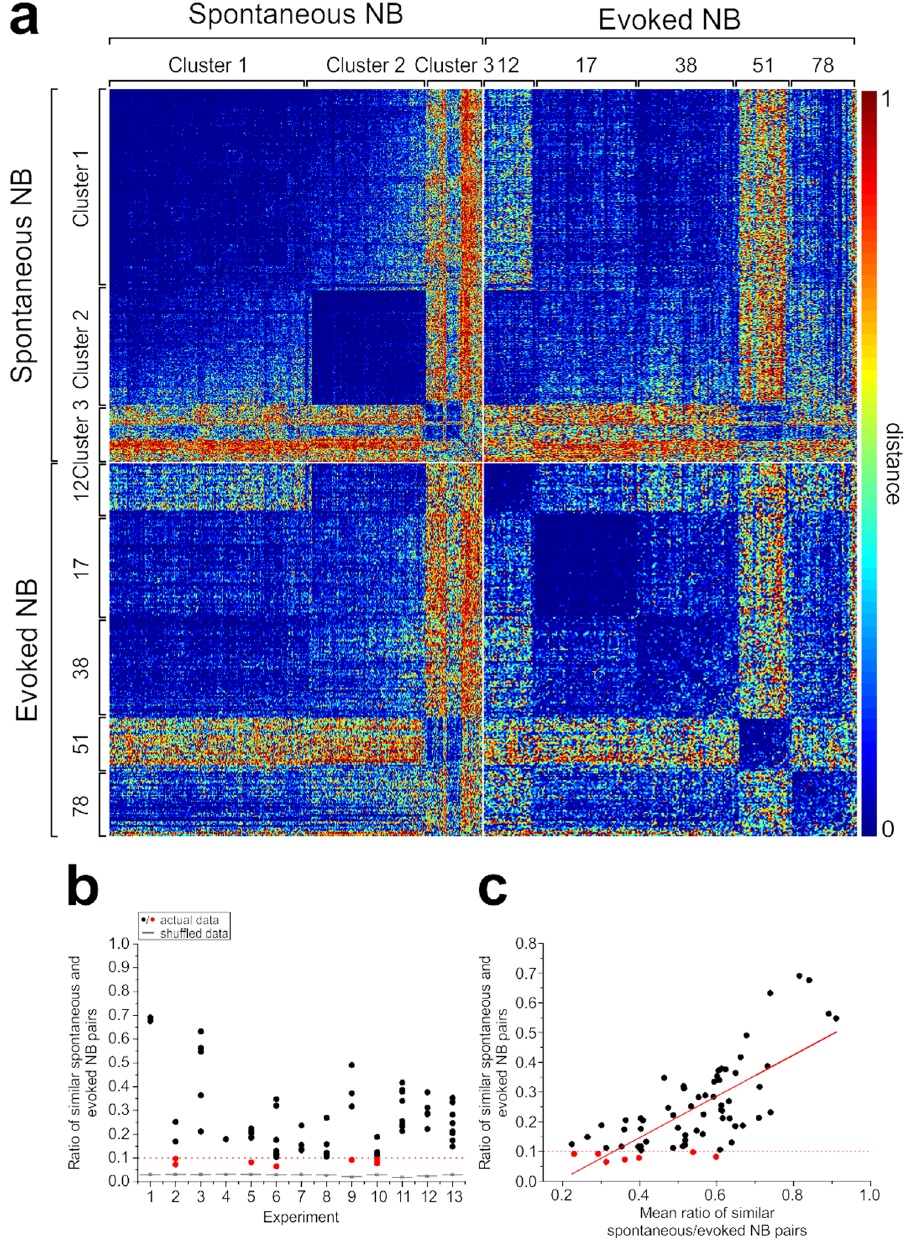
Figure 5. Spontaneous and evoked network bursts show similar activation patterns. ( a ) Color-coded matrix of normalized distances among all pairs of NBs, both spontaneous and evoked, for a representative experiment. NBs have been re-ordered according to the pattern clustering procedure, run separately on spontaneous and on evoked patterns. Cluster and stimulated electrode numbers have been reported aside. ( b ) Maximum ratio of similar spontaneous and evoked NB patterns (as a measure of similarity), for each stimulated electrode as a function of the experiment number (x-axis). Each point represents a stimulated electrode, in black showing ratio > 0.1, in red ratio < 0.1. Statistical distributions of the same parameter computed between shuffled spontaneous and evoked patterns are reported for each experiment in the grey box-plots. The grey shaded area highlights the experiment shown in ( a ). ( c ) Scatter plot of the ratio of similar spontaneous and evoked patterns (already shown in b ) as a function of the mean ratio of similar patterns in the corresponding spontaneous and evoked clusters. The red line indicates the best linear fitting (Pearson’s correlation coefficient 0.73, = . ⋅ − p 2 85 10 12 , adjusted R-square